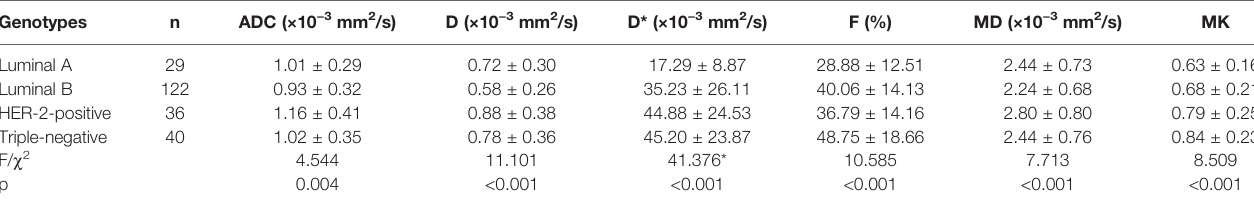
TABLE 4 | Diagnostic performance of DWI, DKI, and IVIM parameters in different genotypes of breast cancer.